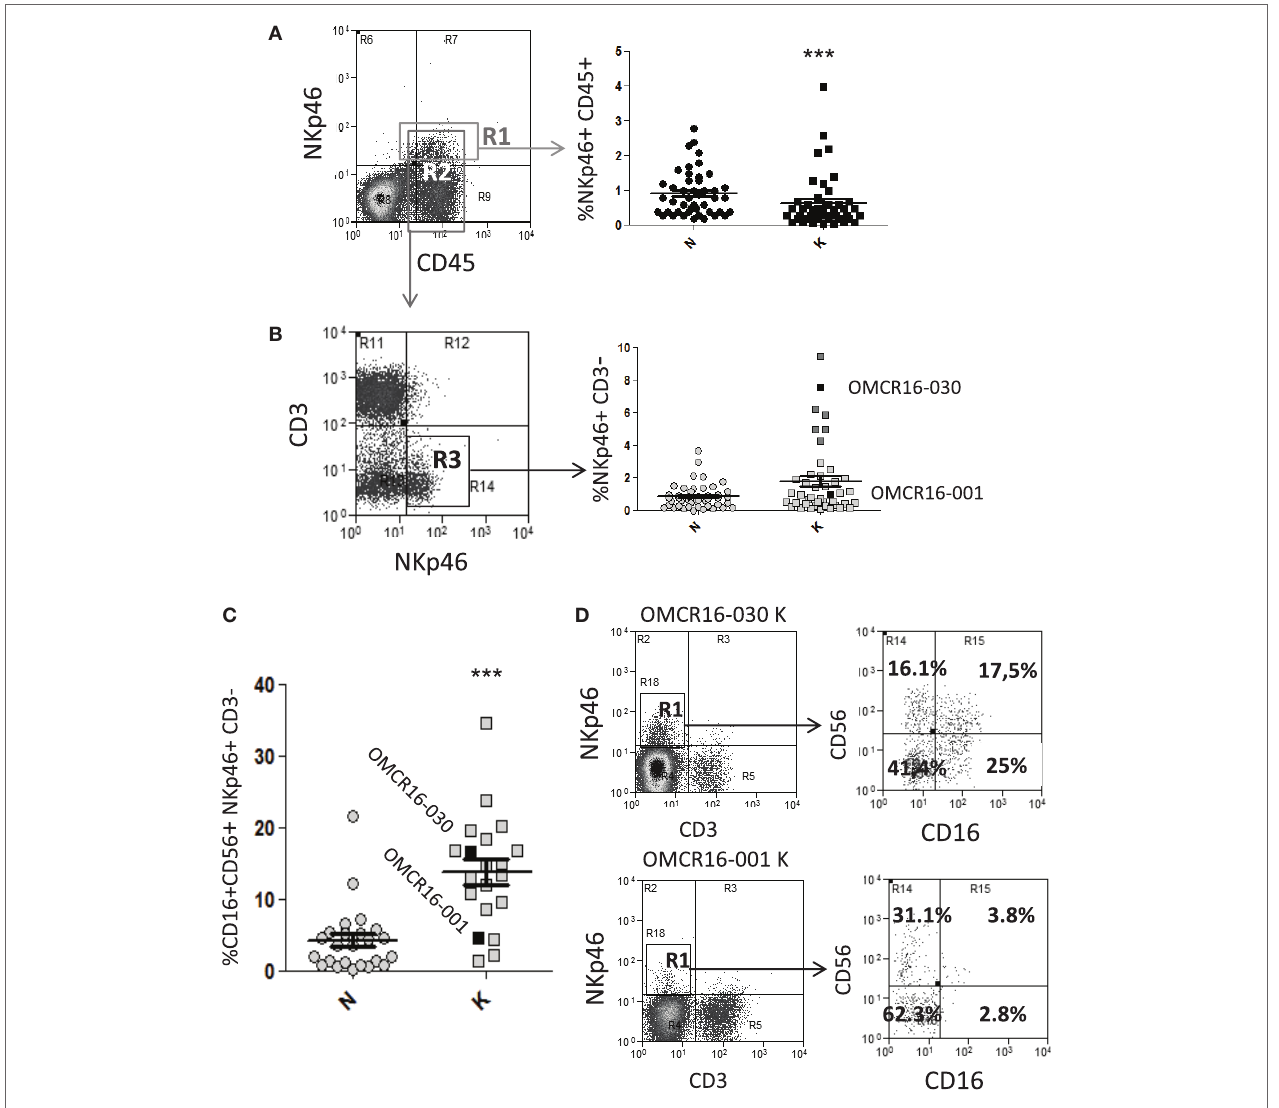
FigUre 5 | CRC cell suspensions contain infiltrating NKp46 + CD16 + natural killer (NK) cells. (a,B) CRC cell suspensions obtained from the tumor (K) or the non-tumor (N) areas of 45 specimens were stained with the anti-CD45 T205, the anti-CD3 JT3A, followed by FITC-anti IgM and APC-anti-IgG2a goat anti-mouse antiserum and PE-anti-NKp46 monoclonal antibodies (mAbs), and analyzed by FACS. Panel (a) , left: dot plot of immunofluorescence of a representative case of CRC. R1: gate on NKp46 + CD45 + cells, R2: gate on CD45 + cells. Panel (a) , right: percentage of NKp46 + CD45 + cells in gate as R1 in 45 CRC. *** p < 0.001, non-parametric two-tailed t test Mann–Whitney. Panel (B) , left: dot plot of immunofluorescence on gate R2 of the sample depicted in panel (a) . R3: gate on NKp46 + CD3 − cells. Panel (B) , right: percentage of NKp46 + CD3 − cells in gate R3 in 45 CRC. The two cases indicated with black squares (OMCR16-030, above the mean and OMCR16-001, below the mean) are shown in more detail in panel (D) . Dark gray squares indicate the six cases, besides OMCR16-030, with NKp46 + CD3 − cells between 4 and 10%, (c) CRC cell suspensions obtained from the tumor (K) or the non-tumor (N) areas of 20 specimens were stained with the PE/Dazzle-anti-CD3, PE-Cy7-anti-NKp46, PE-Cy5-anti-CD56, and Pacific Blue-anti-CD16 mAbs. CD56 + CD16 + cells among the NKp46 + CD3 − cell population. *** p < 0.001, non parametric two-tailed t test Mann–Whitney. Black squares: OMCR16-030 and OMCR16-001. (D) CD56 and CD16 expression (right dot plots) on the NKp46 + CD3 − tumor cell population (K, gated in R1, left dot plots) of the two cases indicated with black squares in panels (B,c) (OMCR16-030 and OMCR16- 001). In each quadrant: percentage of positive cells.